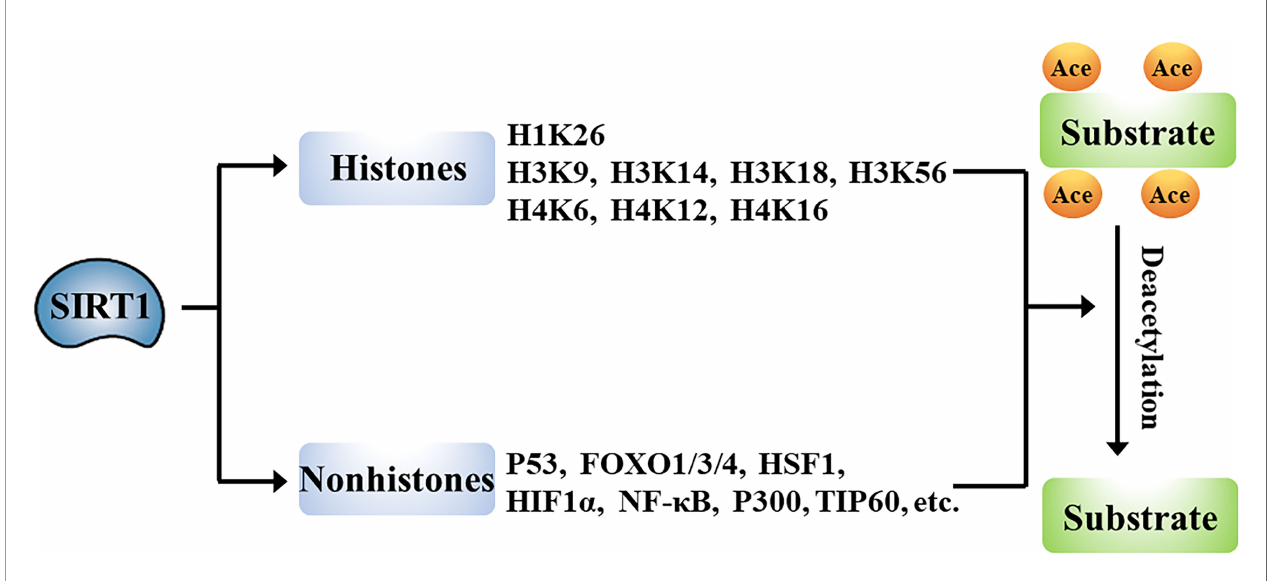
FIGURE 2 | Schematic overview of the genes targeted for deacetylation by SIRT1.